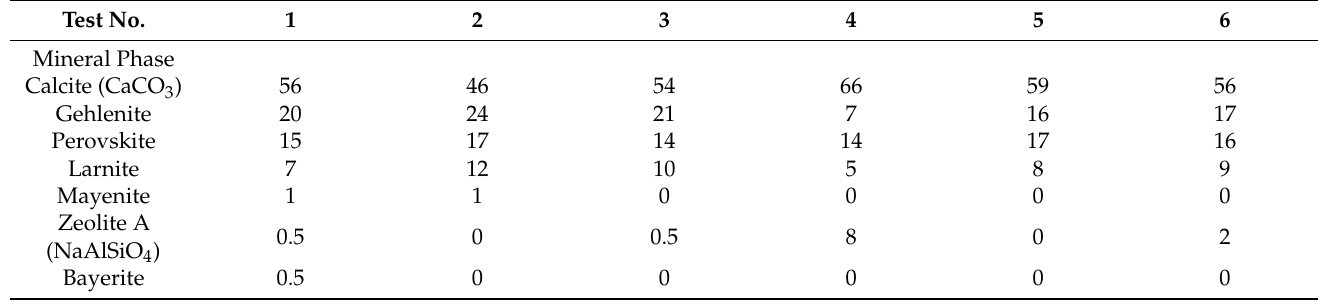
Table 7. XRD semi-quantitative analysis of the grey mud samples (wt%). Table 7 . XRD semi-quantitative analysis of the grey mud samples (wt%) .